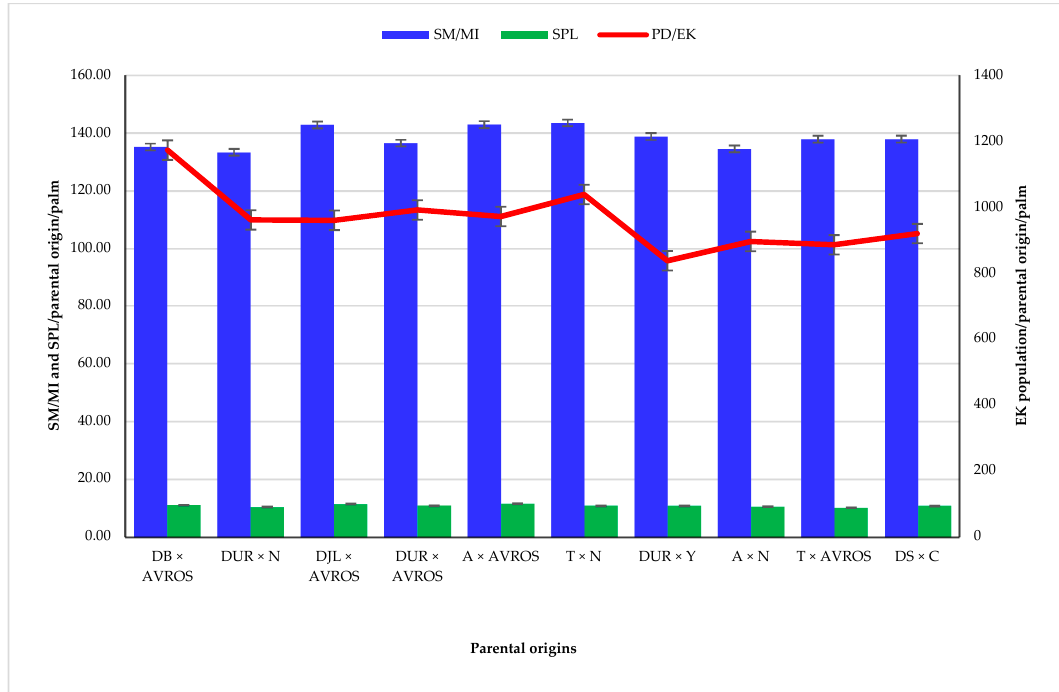
Figure 6. Spikelet means per male inflorescence and population means of Elaeidobius kamerunicus on male inflorescence among the dura and pisifera genetic origins: SM/MI, number of spikelets per male inflorescence; PD/EK population force of Elaeidobius kamerunicus ; AVROS, Algemene Vereniging Rubber planters; DB × AVROS, Deli Banting × AVROS; DUR × N, Deli Ulu Remis × Nigeria; DJL× AVROS, Deli Johor Labis; DUR × AVROS, Deli Ulu Remis × AVROS; A× AVROS, Angola × AVROS; T × N, Tanzania × Nigeria; DUR × Y, Deli Ulu Remis × Yangambi; A × N, Angola × Nigeria; T × A, Tanzania × AVROS; DS × C, Deli Serdang × Cameroon.